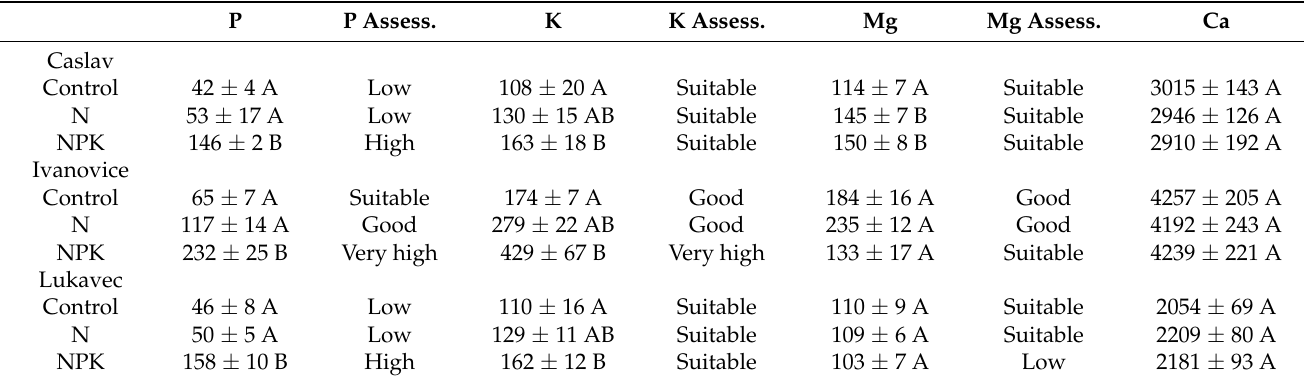
Table 5. The concentrations of P, K, Mg and Ca in the soil profile according to the locality and fertilizer treatment. P P Assess. K K Assess.